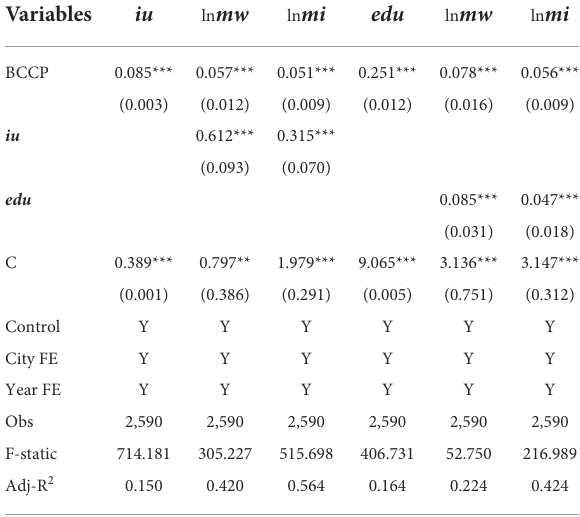
TABLE 6 Mechanisms of information infrastructure affects the health care